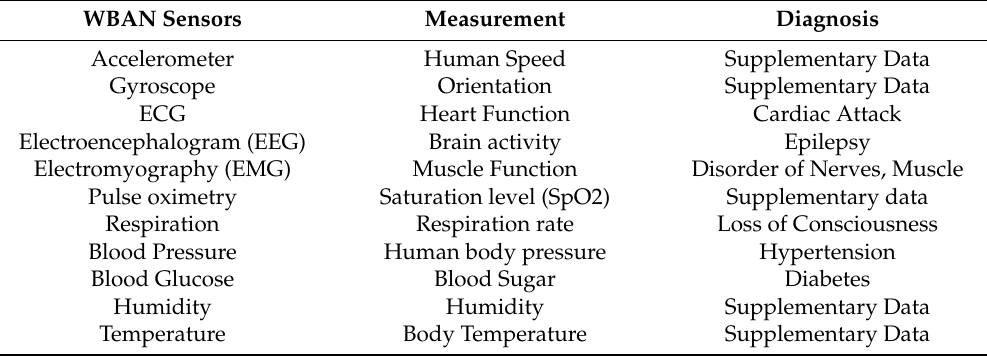
Table 1. Commonly employed WBAN sensors with their measurement and possible